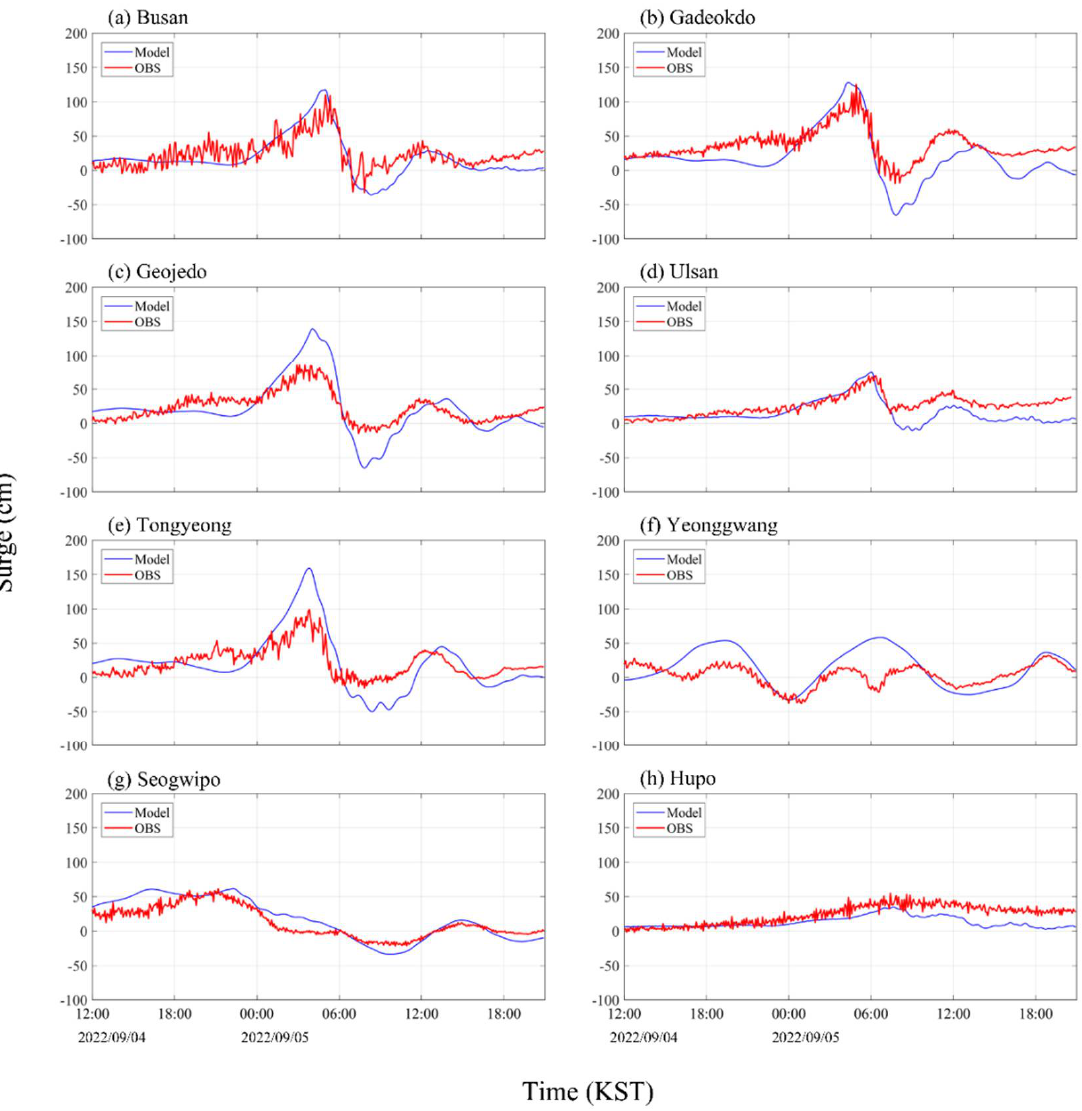
Figure 5. Surge model simulation results and KHOA observations at ( a ) Busan, ( b ) Gadeokdo, ( c ) Geojedo, ( d ) Ulsan, ( e ) Tongyeong, ( f ) Yeonggwang, ( g ) Seogwipo, and ( h ) Hupo from 4 to 5 September in 2022.